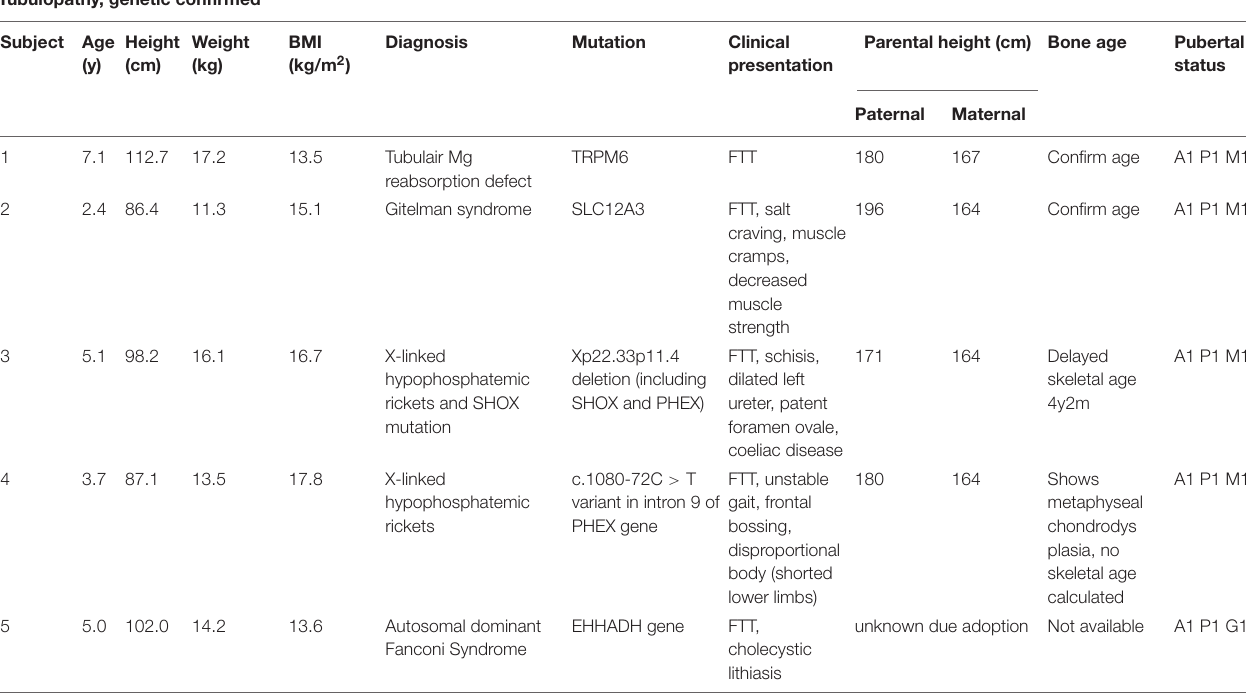
TABLE 1 | Overview of the patients’ characteristics with a genetically proven tubulopathy. Tubulopathy, genetic confirmed